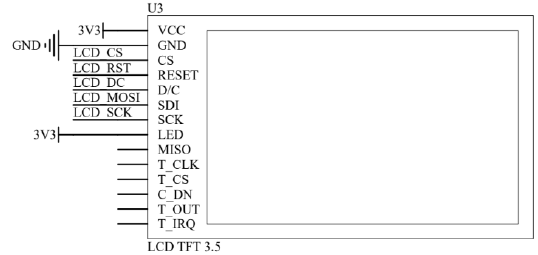
Figure 3. TFT LCD